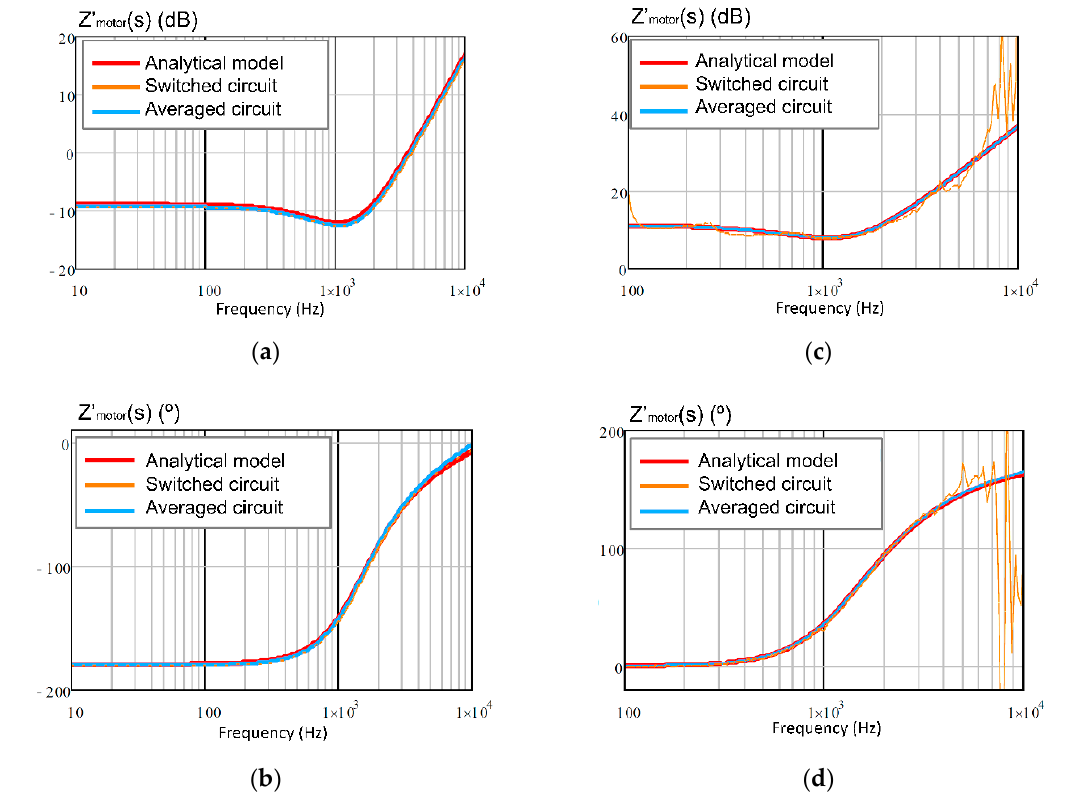
Figure 23. Frequency response of the small-signal input impedance, Z´ motor (s) , of the motor drive-